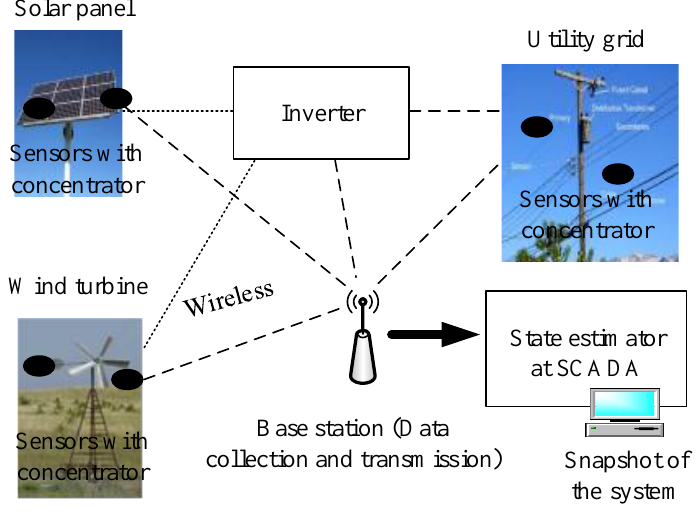
Figure 5. DER state information is coordinated by wireless sensor in the smart grid.